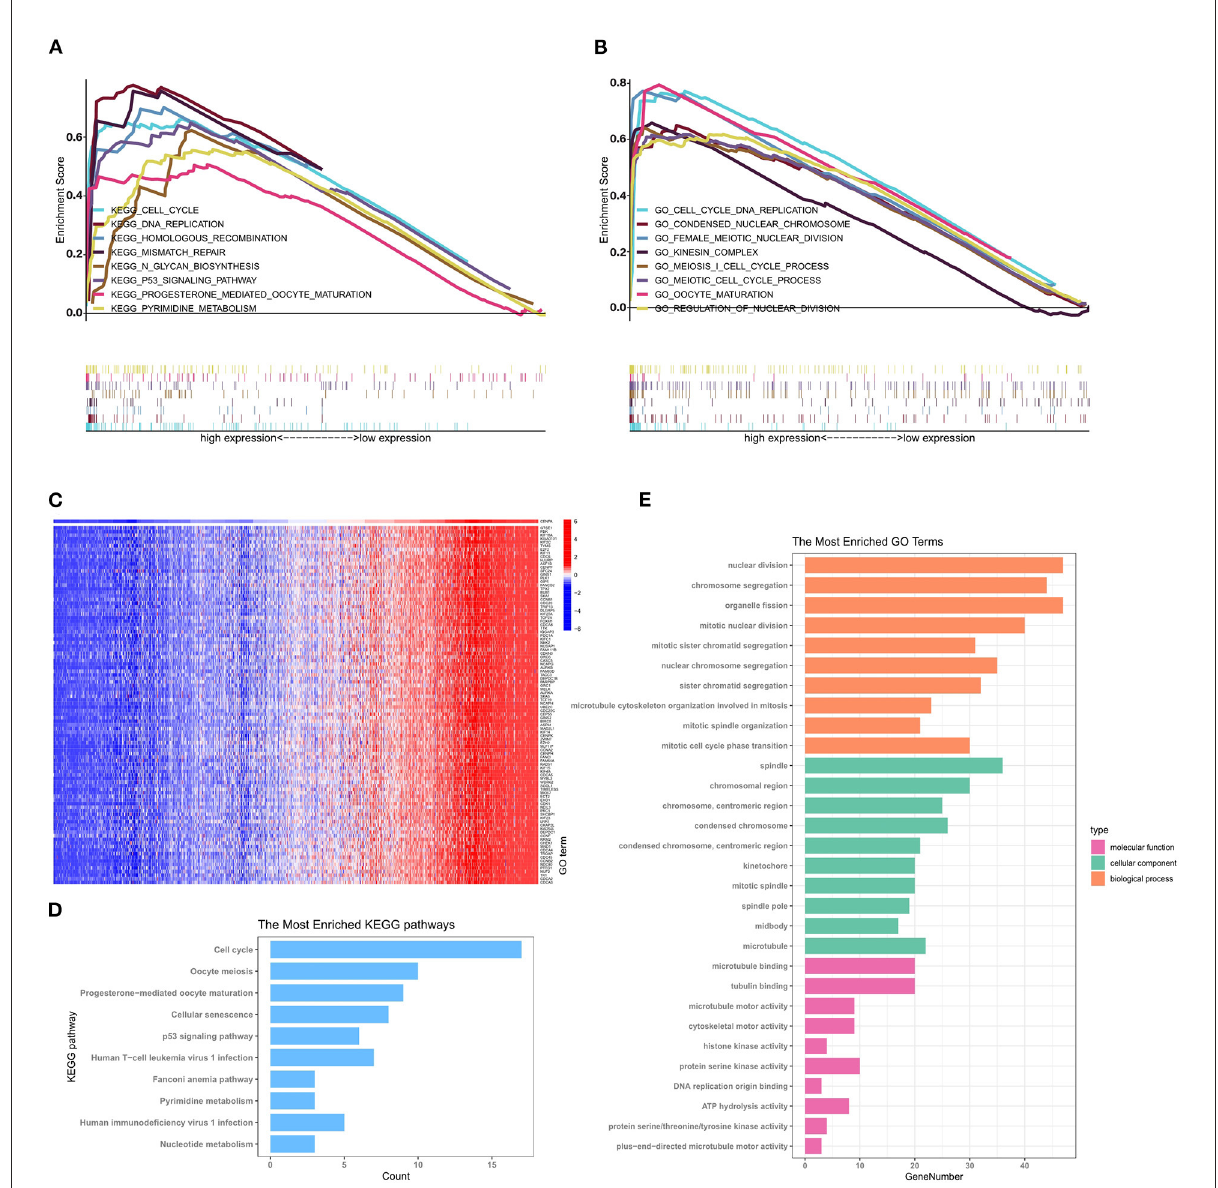
FIGURE6 GSEA, GO analysis, and KEGG enrichment analysis reveal the potential mechanism by which CENPA promotes glioma progression using the CGGA database (LGG + GBM). The top 8 gene ontologies (A) and KEGG pathways (B) based on the normalized enrichment score (NES) between the high- and low-CENPA expression phenotypes. (C) Pearson correlation coefficient heatmap of the top 100 genes positively related to CENPA. The top 10 KEGG pathways (D) and biological processes, cellular components, and molecular functions (E) of the top 100 genes co-expressed with CENPA in